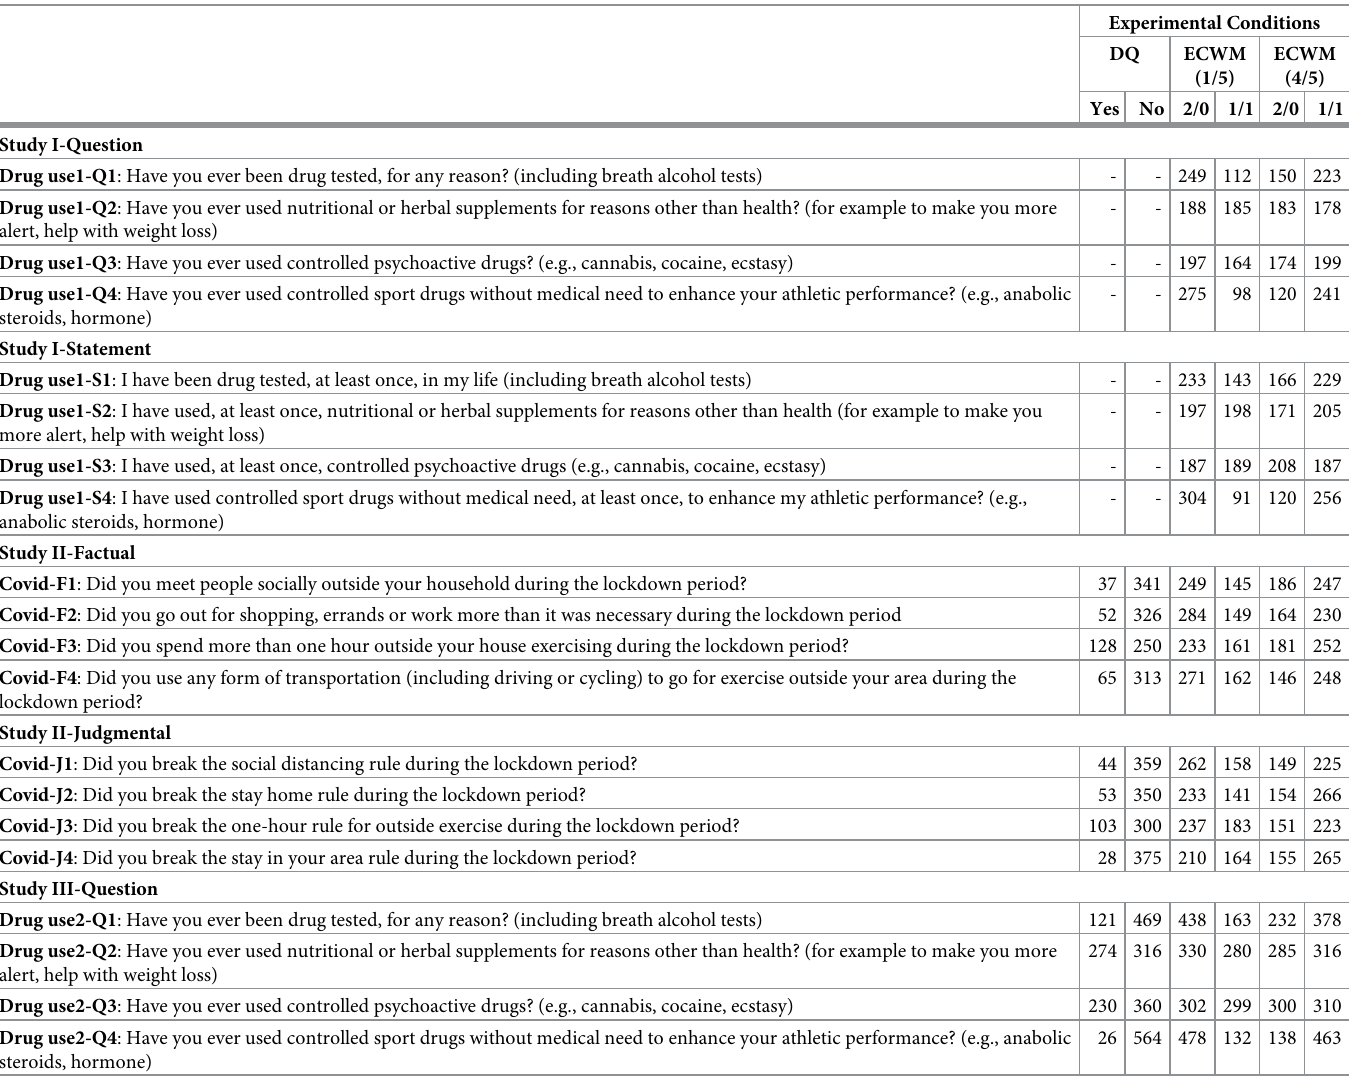
Table 1. Observed response frequencies of Studies I, II, and